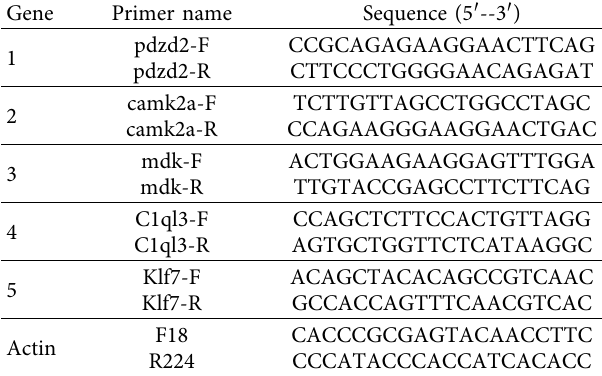
Table 1: RT-q PCR